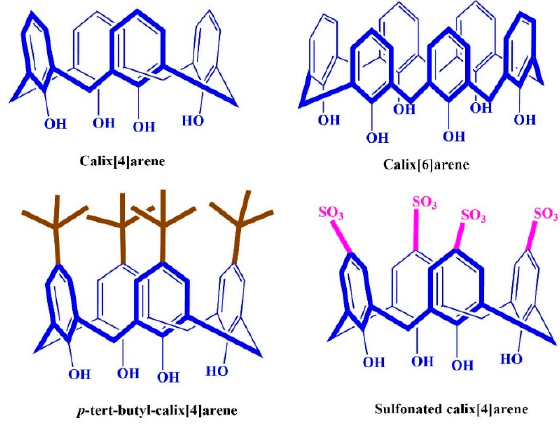
Figure 1. Chemical structure of calixarene derivatives.